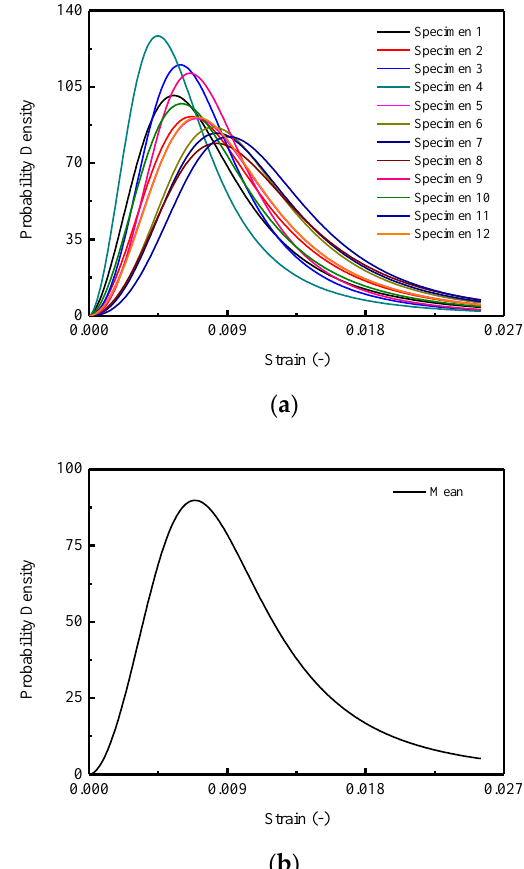
Figure 14. Stochastic probability density of micro-damage thresholds of CA mortar under compression: ( a ) 12 CA mortar specimens; ( b ) The mean curve.